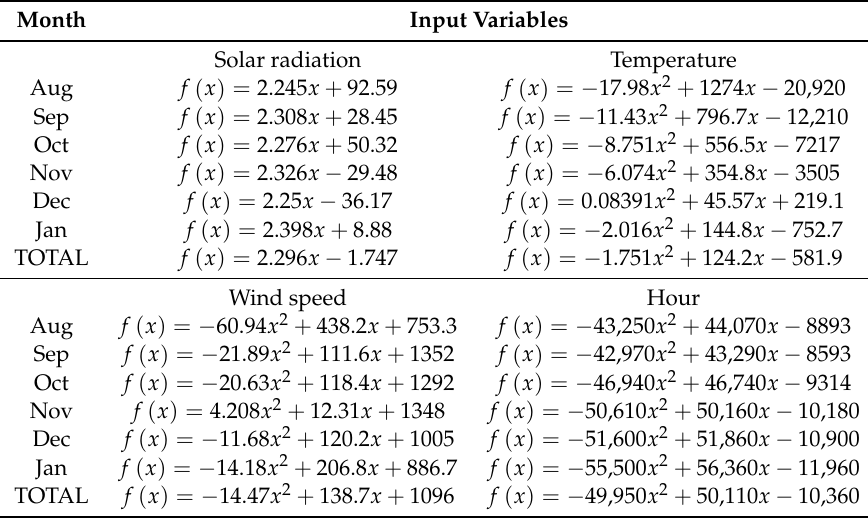
Figure 7. The Power vs. Time of HS. Table 2. The fitted curve characteristic equation of every input from